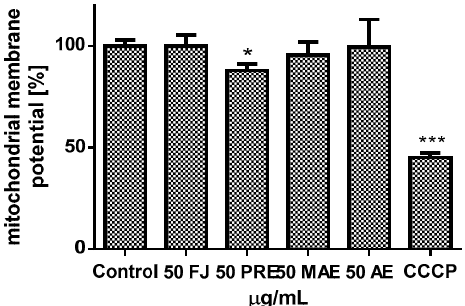
Figure 8. The V. opulus juice (FJ), PRF (phenolic rich fraction) MAE (methanol-acetone extract) and AE (acetone extract) (at 50 μ g/mL dosage) influence on mitochondrial membrane potential was determined with JC-1 probe. As a positive control for depolarization, carbonyl cyanide m-chlorophenyl hydrazine (CCCP ) (50 μ M) was used; control cells were not exposed to any compound but the vehicle; values are means ± standard deviations from at least three independent experiments; statistical significance was calculated versus control cells (untreated) * p ≤ 0.05, *** p ≤ 0.001. Due to the observed decrease in intracellular ATP production and the intensive elevation of ROS we suspected that cellular death may be triggered. Thus, we carried out analysis of putative impact